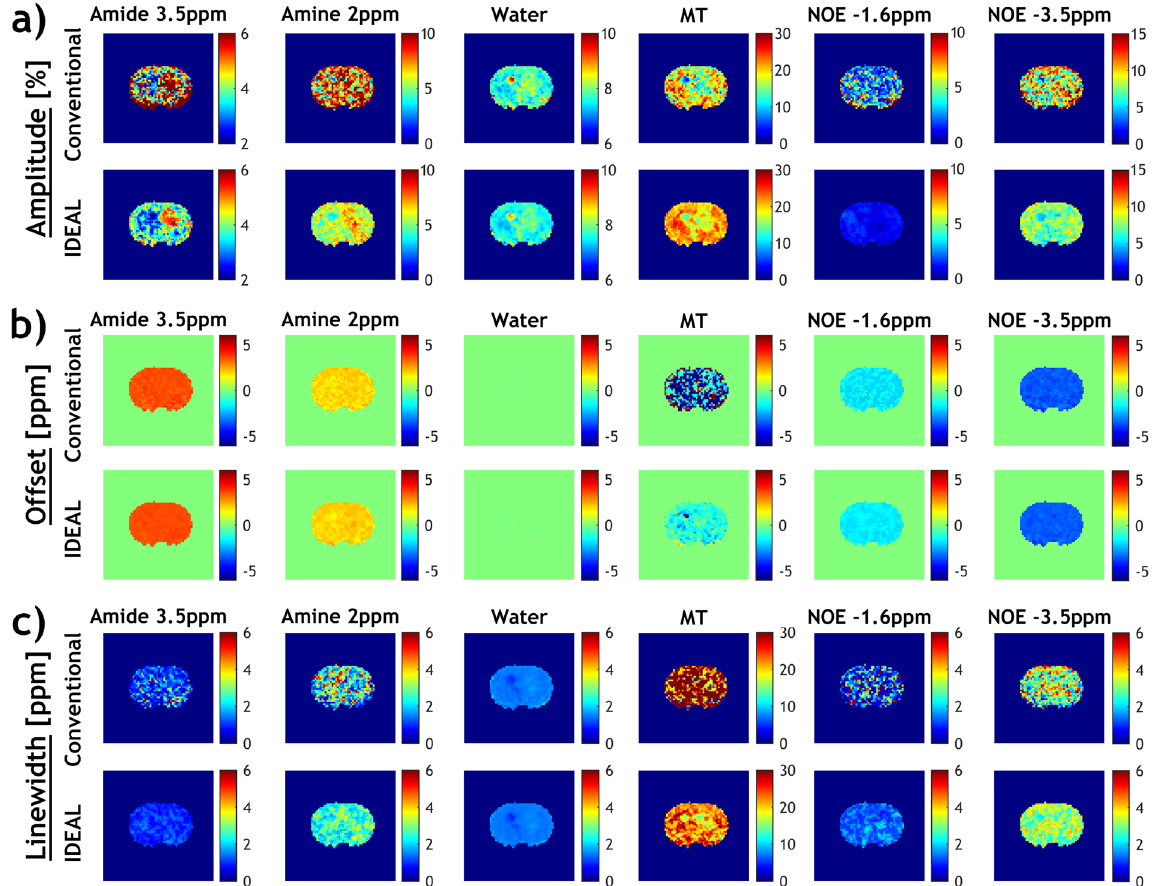
Figure 6. Fitted amplitude, frequency offset and linewidth maps of each pool using conventional fitting and IDEAL fitting in a representative rat brain with glioma.